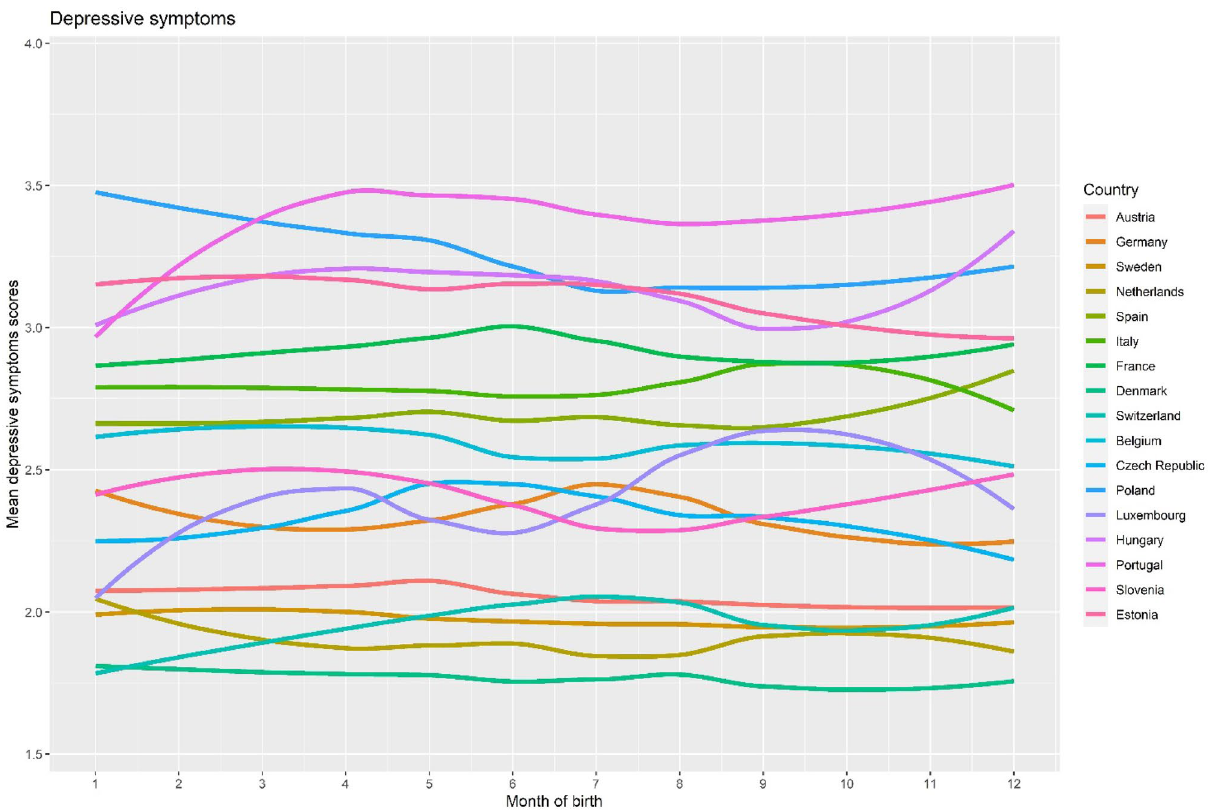
Figure 1. Mean depressive symptoms by country and month of birth (depressive symptoms scores ranged between 0 to 12; smoothing splines were fitted against mean